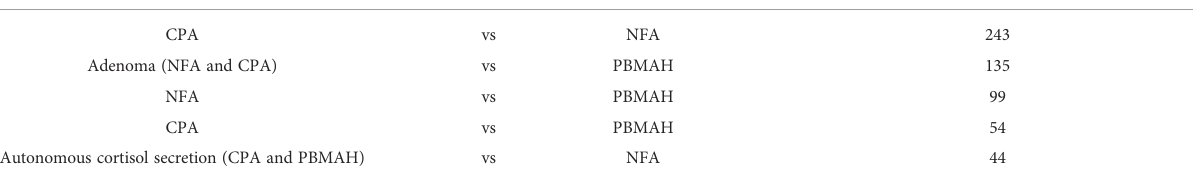
TABLE 2 Number of differentially expressed miRNAs when comparing tumor